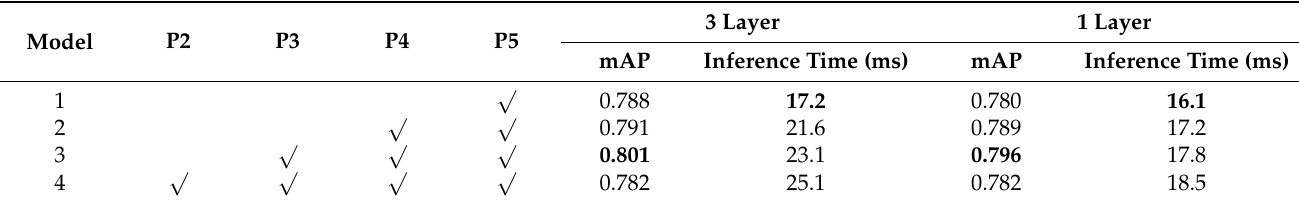
Table 3. Comparison of CA module location and number of